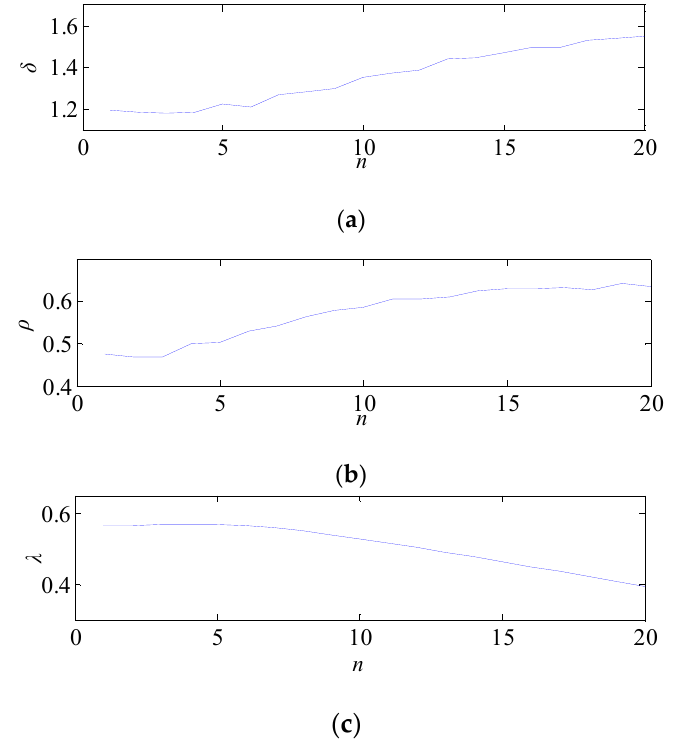
Figure 10. The relationship between r and ( a ) δ , ( b ) ρ , or ( c ) λ .